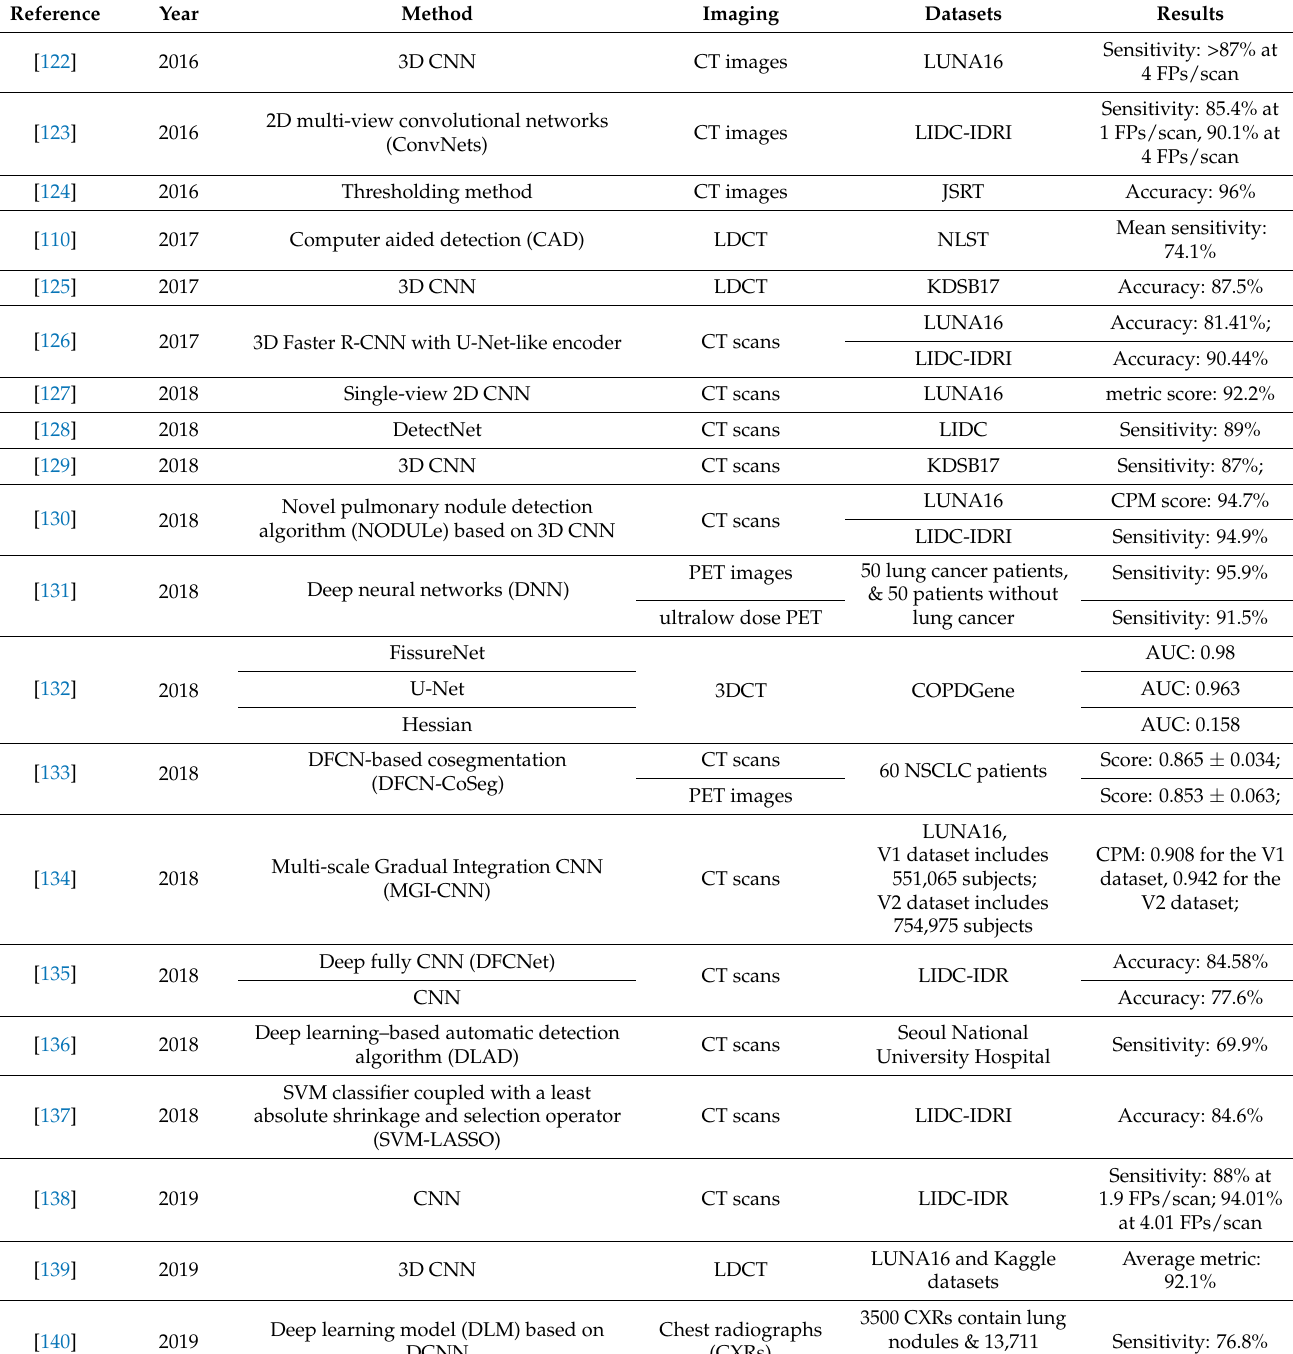
Table 3. Lung nodule detection